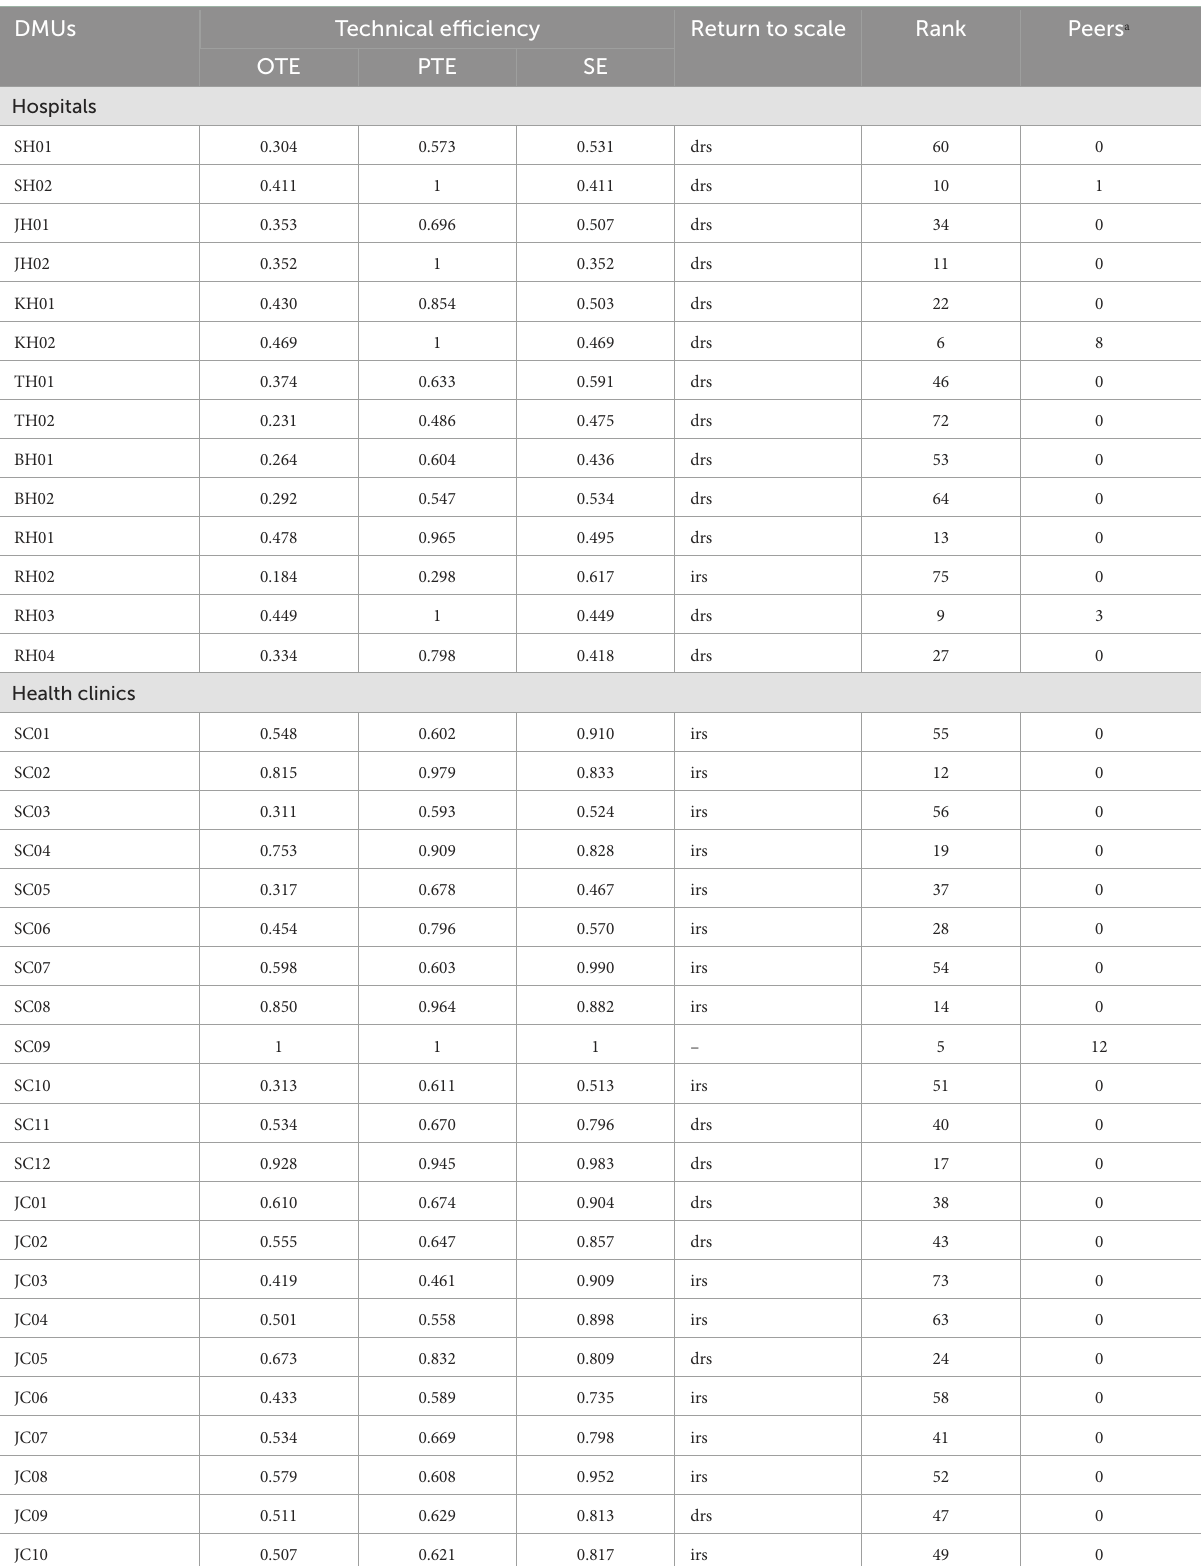
TABLE 2 DEA efficiency score of ambulance services for hospitals and clinics ( n = 76).